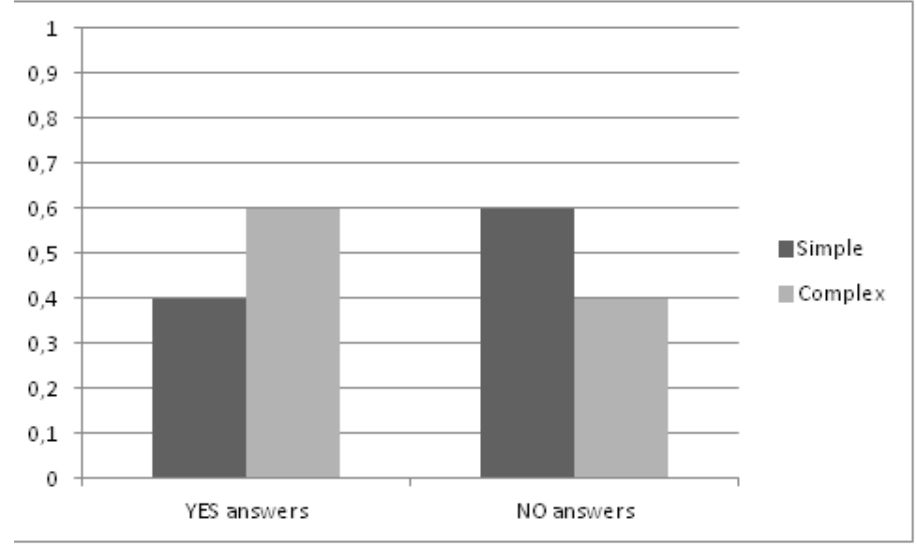
Figure 15 . Proportion between YES and NO answers for convencer -sentences: Effect of the syntactic complexity of the wh